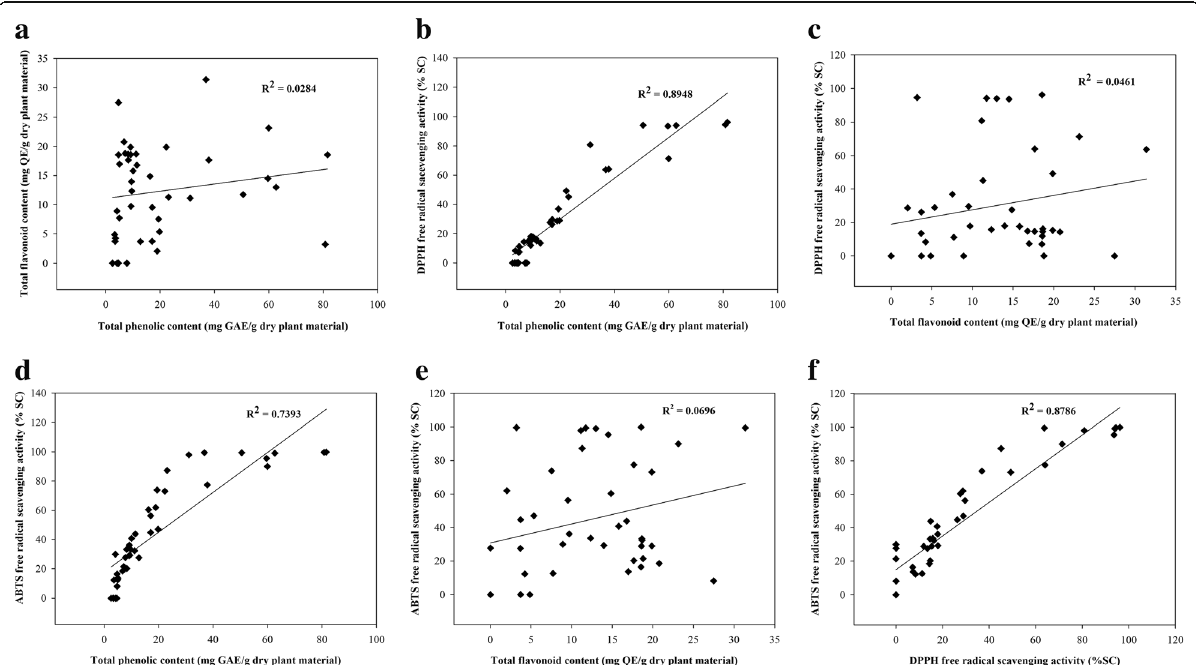
Fig. 1 Correlation Analyses. Values in Tables 2 through 4 were evaluated by linear regression analysis, and correlation coefficients expressed as R 2 are shown in the panels. a Total flavonoid content in mg QE/g dry material versus Total phenolic content in mg GAE/g dry material. b DPPH